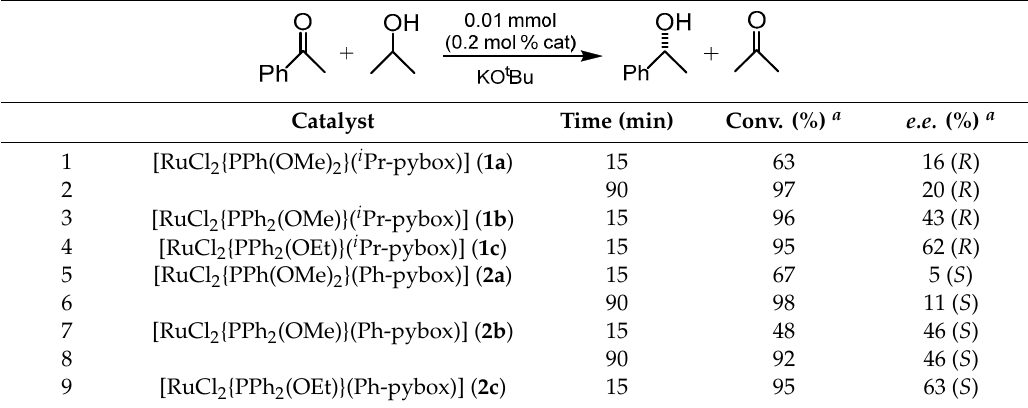
Table 1. Asymmetric Transfer Hydrogenation of Acetophenone Catalyzed by Ruthenium(II) Complexes 1a – c and 2a–c.